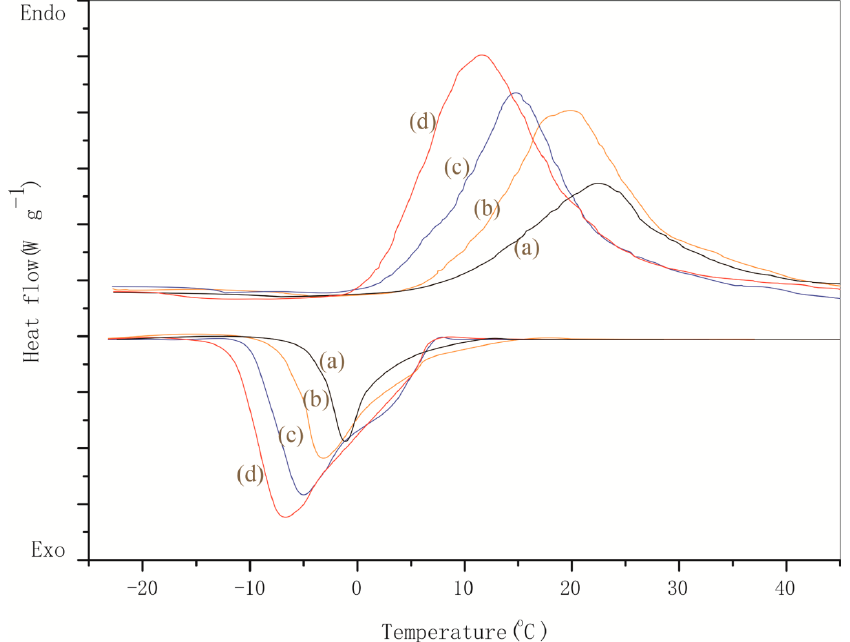
Figure 14. Differential Scanning Calorimetry (DSC) curves of microPCM samples with/without graphene, ( a ) MG-0; ( b ) MG-2; ( c ) MG-4 and ( d ) MG-6.